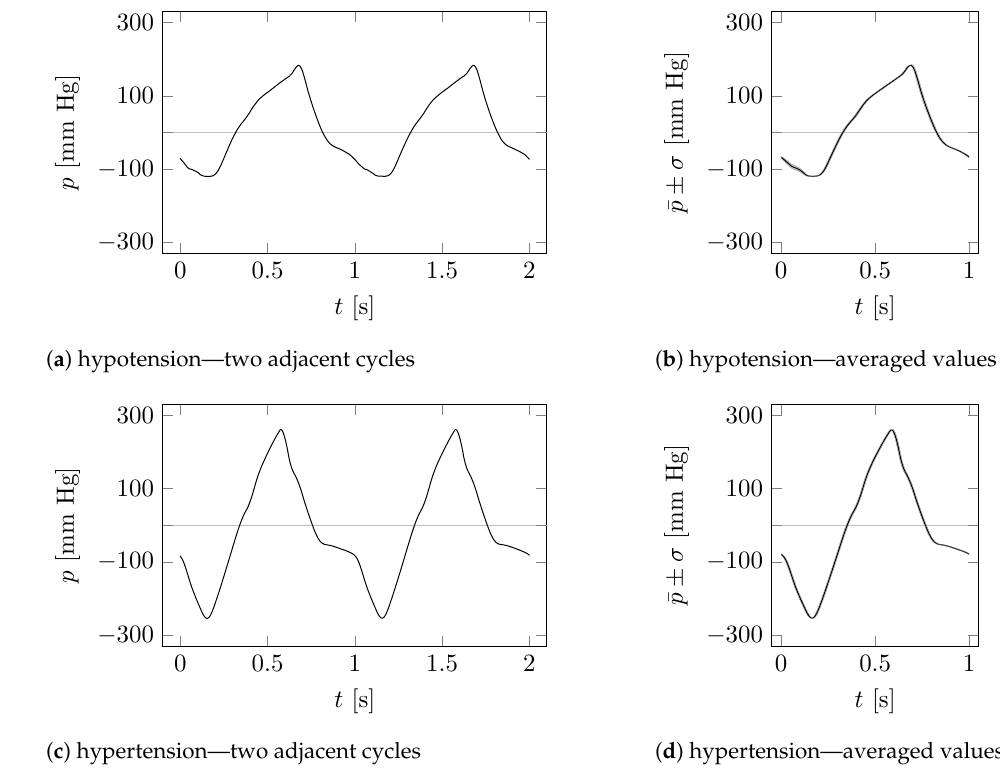
Figure 8. Experimental results—balloon